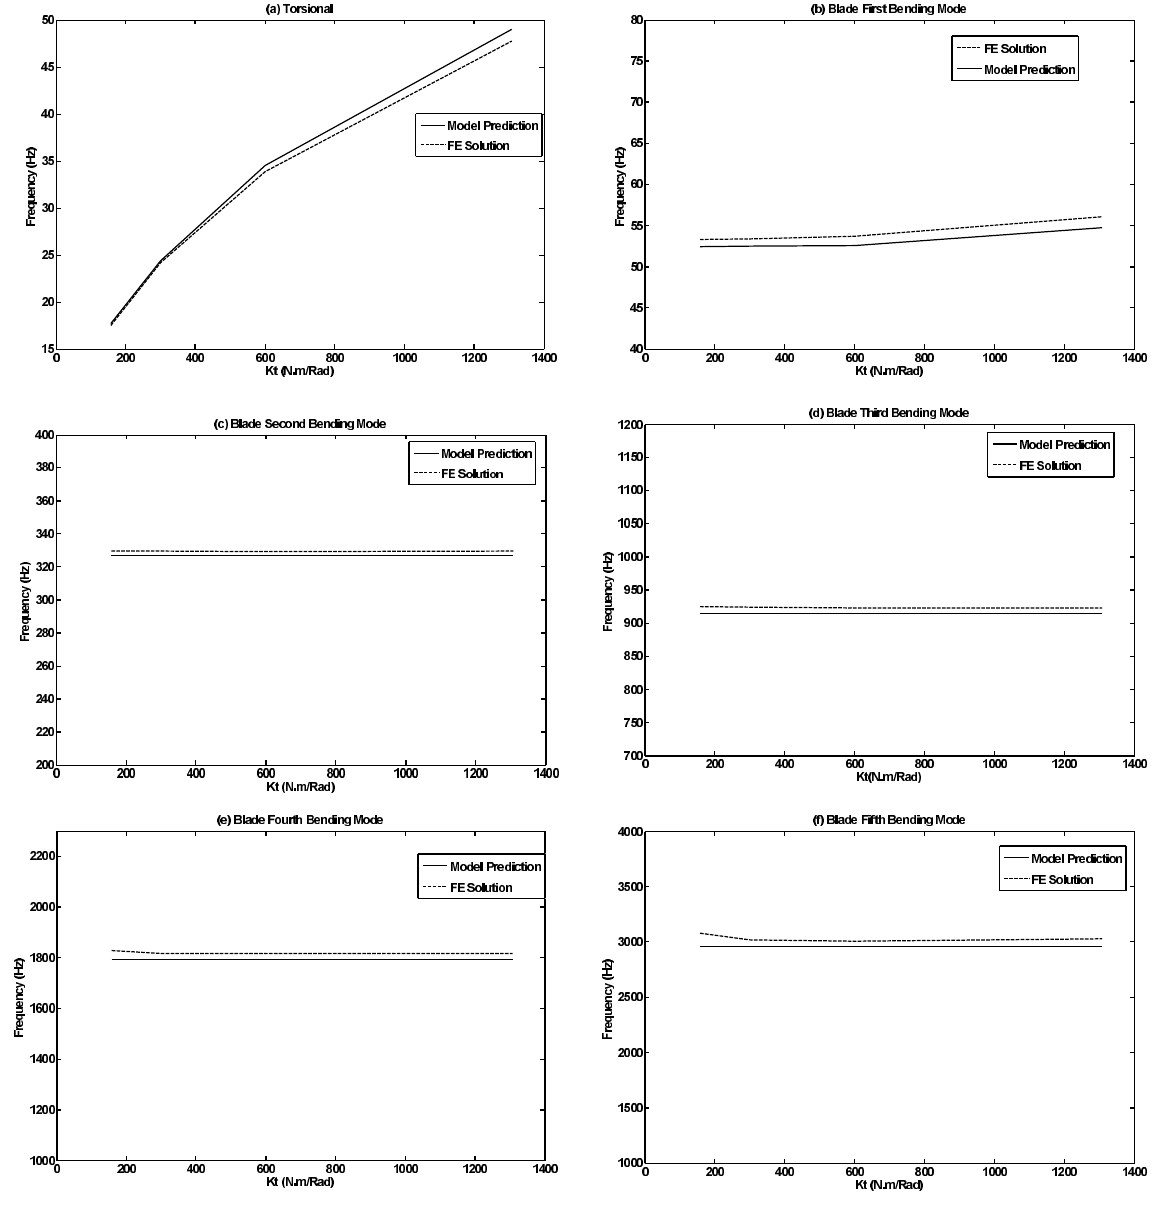
Fig. 9. Natural frequencies as function of k T Comparison for both Predicted Model and FE